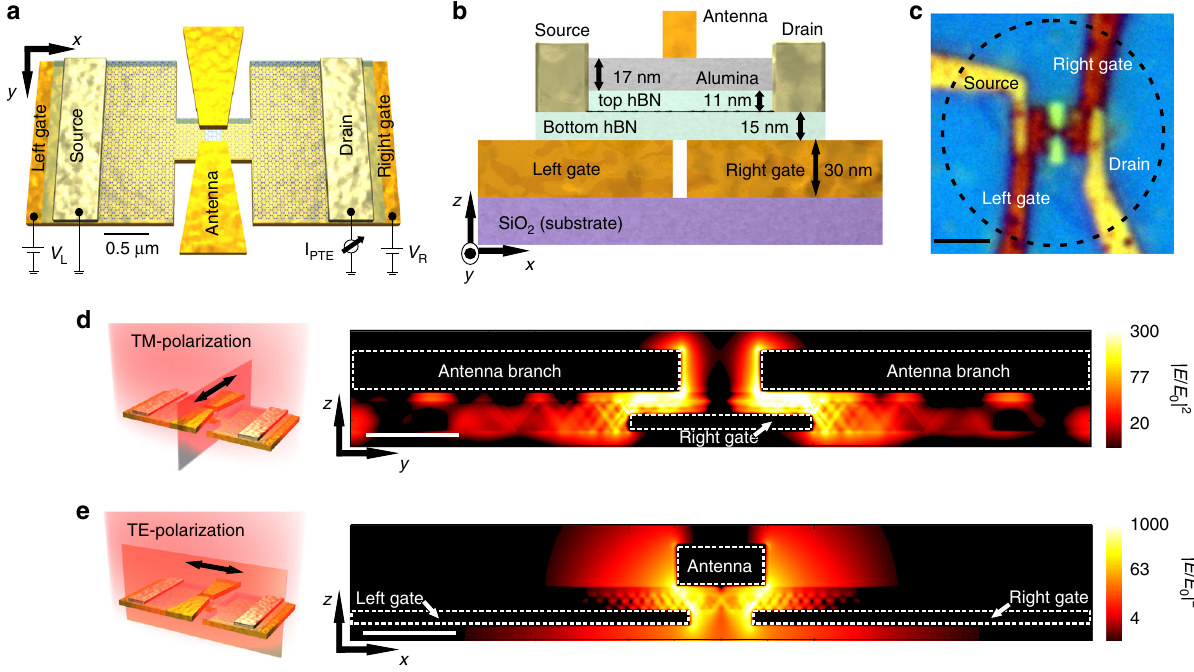
Fig. 1 Device schematic and operation principle. a Schematic representation of the photodetector consisting of H-shaped resonant gates of 4.2 μ m of total length, with a hBN-encapsulated H-shaped graphene channel transferred on top, contacted by source and drain electrodes. A bow-tie antenna of 2.7 μ m of total length is placed on top of the 2D stack. The local gates serve to create a pn -junction in the central part of the graphene channel (by applying voltages V V L and R ), where the antenna gap and gate gap are located. Both narrow gaps are on the order of ~100 nm. The scale bar corresponds to 0.5 view of the device design (not to scale) with indications of the materials' thicknesses. c Optical image of the photodetector. The dashed lined circle indicates the typical beam spot size obtained at λ = 6.6 μ m. The scale bar corresponds to 2.5 μ m. d Cross section view of the simulated total electric fi eld intensity ( ∣ E ∣ 2 ) normalized to the incident one ( ∣ E 0 ∣ 2 ) along the antenna main axis when light is polarized parallel to the bow-tie antenna (TM-polarization) axis as indicated in the illustration on the left. The white scale bar corresponds to 250 nm. e Same as ( d ) but for light polarization perpendicular to the bow- tie antenna (TE-polarization) and parallel to the local gates as shown in the schematic on the